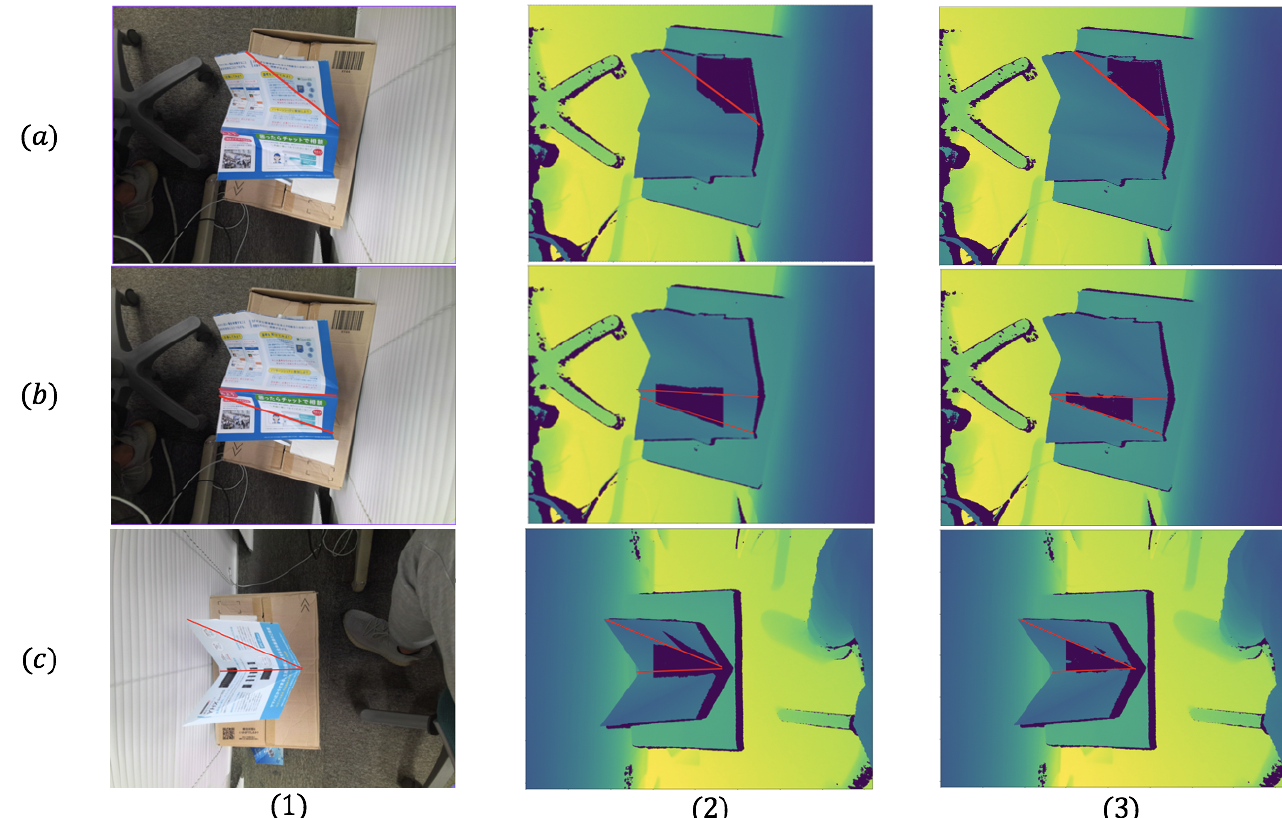
Figure 16. Three cases for region growing (The red line marks the bending line): ( 1 ) the RGB images of three cases; ( 2 ) the region growing method of [57]; ( 3 ) our approach; ( a , b ) two different planes on a same paper; ( c ) a plane on another different